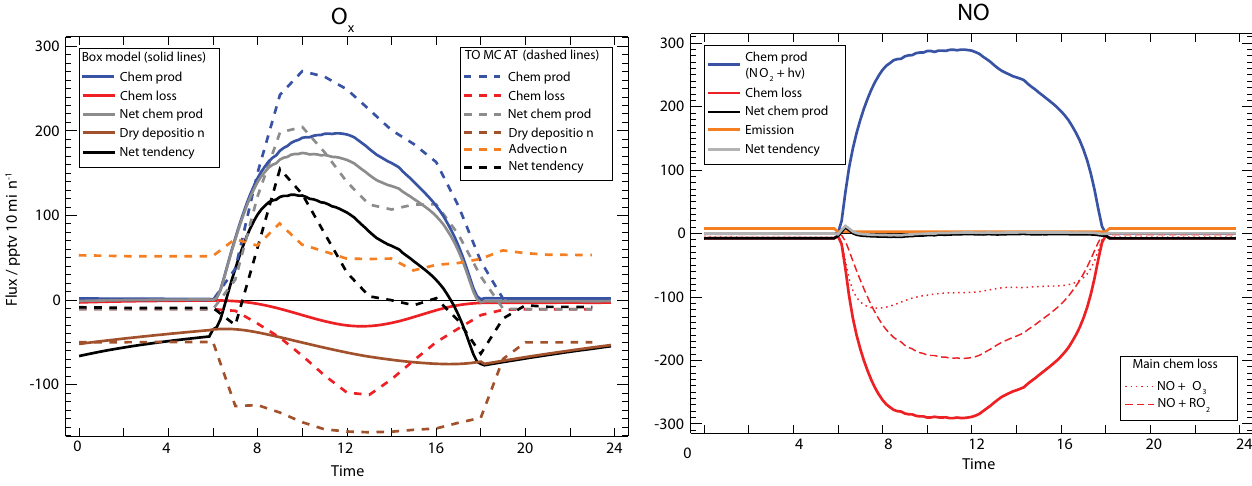
Fig. 5. Time series of production and loss of O x (left) and NO (right) throughout the day. For both, production is shown in blue, loss is shown in red, and net production is shown in black, and fluxes which make large contributions to the total budget are shown in dashed lines, each of which is indicated in the